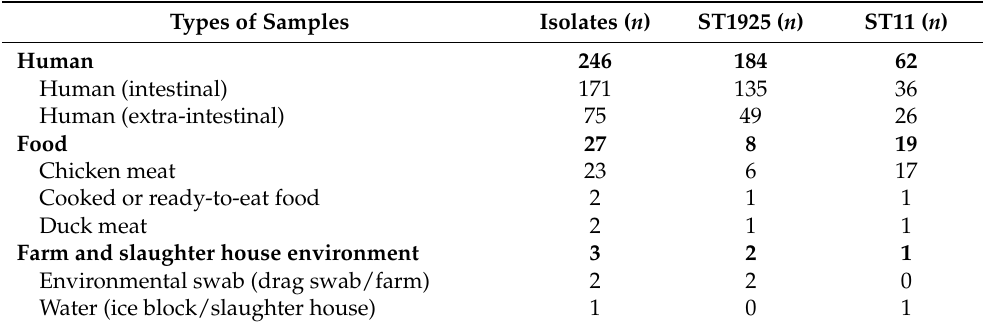
Table 1. Number of S. Enteritidis isolates and respective sequence